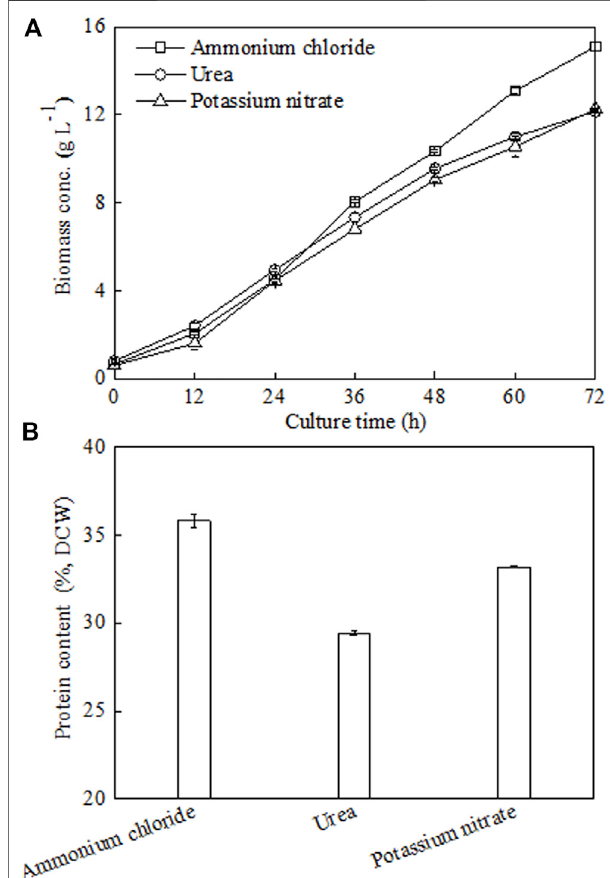
FIGURE 3 | Effects of different nitrogen sources on C. sorokiniana CMBB276 growth (A) and protein content (B) under heterotrophic conditions in 1-l bioreactors. Values are shown as mean ± SD from three biological independent